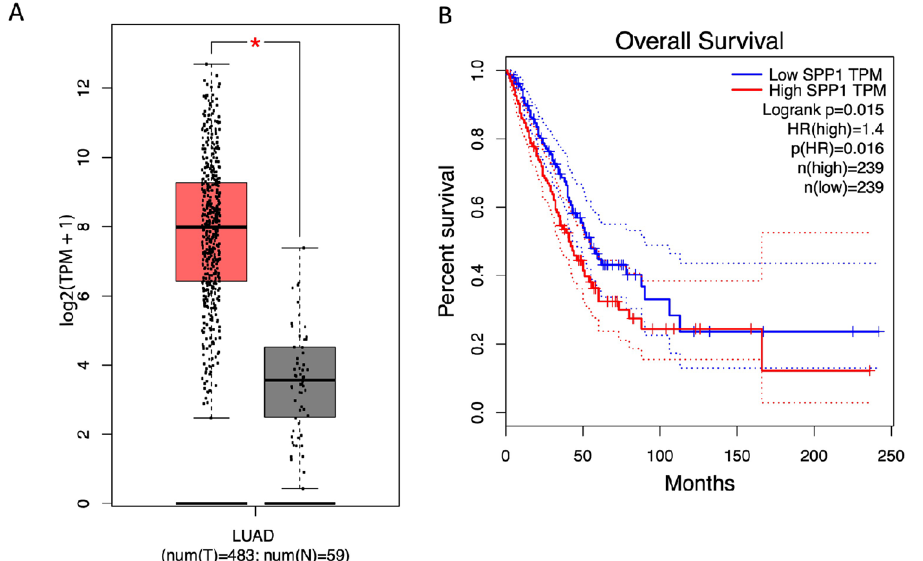
Figure 9. Expression of SPP1 in normal tissue and tumor tissue from The Cancer Genome Atlas Lung Adenocarcinoma datasets ( A ) and Kaplan–Meier survival analysis for SPP1 from TCGA data ( B ). Boxplots show medians, interquartile ranges, and total